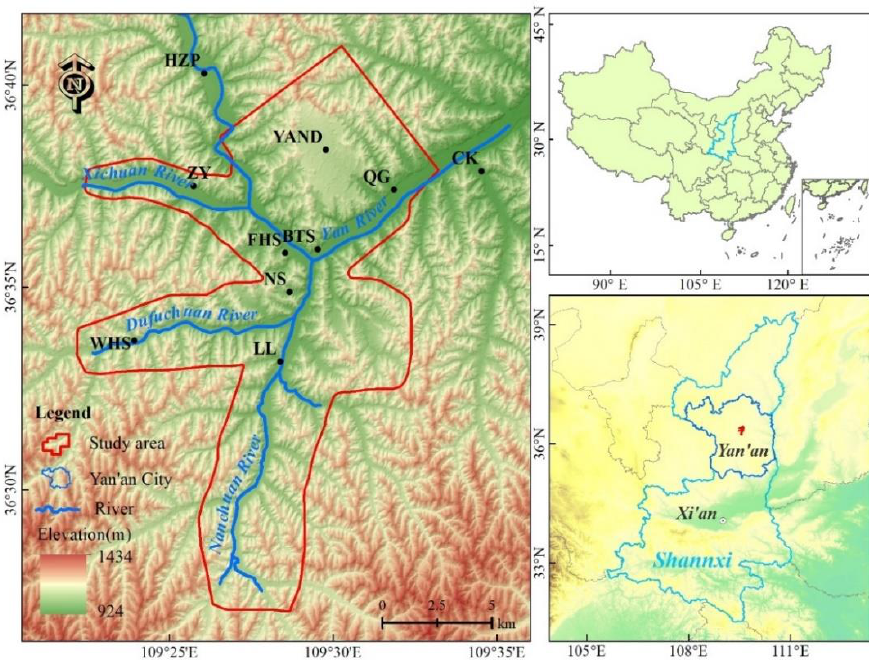
Figure 1. The location, boundary, and geomorphology of the present study area in Yan’an City and Shaanxi Province. YAND—Yan’an New District; HZP—Hezhuangping Town; QG—Qiaogou Street; CK—Chuankou Town; BTS—Baotashan Street; FHS—Fenghuangshan Street; ZY—Zaoyuan Town; NS—Nanshi Street; WHS—Wanhuashan Town; LL—Liulin